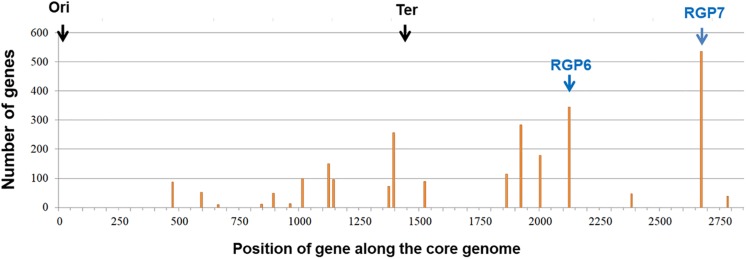
Distribution of hotspots along the core-genome of Acinetobacter baumannii GC1 Group 1 genomes. The gene order of A. baumannii AYE strain was used as a reference (see section “Materials and Methods”). The bars represent the number of different gene families in all the genomes found between two consecutive genes of the core-genome of GC1 genomes.